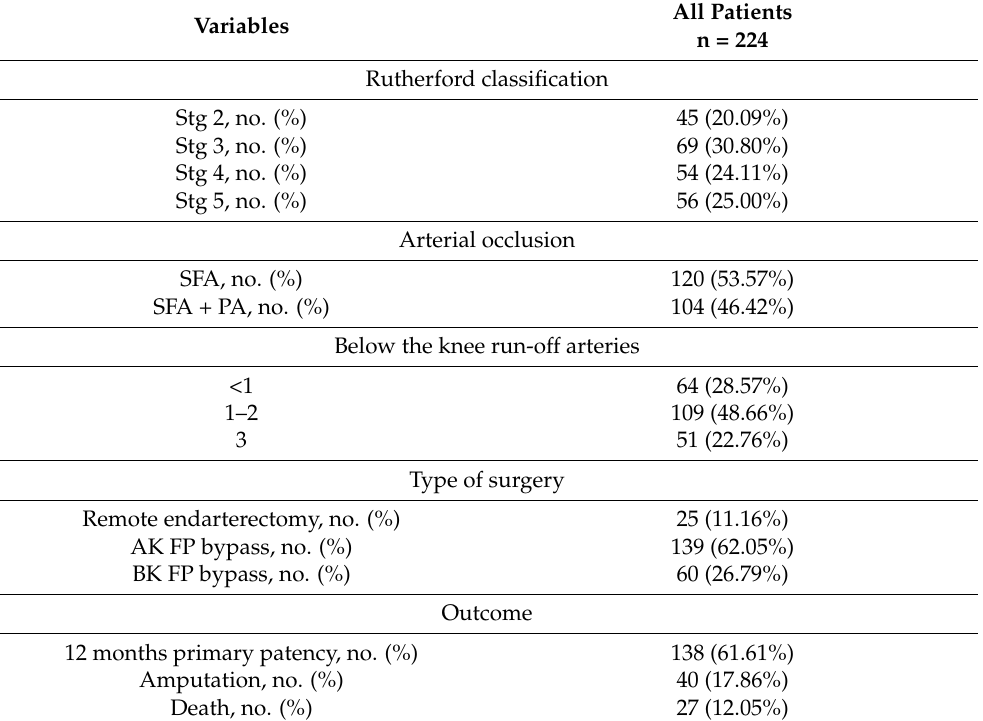
Table 2. Rutherford classification, arterial occlusion, below the knee run-off arteries, type of surgery, and outcome for all patients.